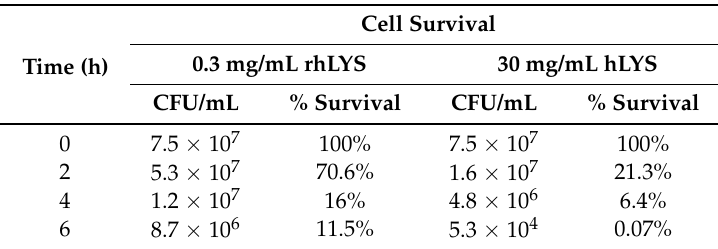
Table 1. Sensitivity of H. pylori to rhLYS.